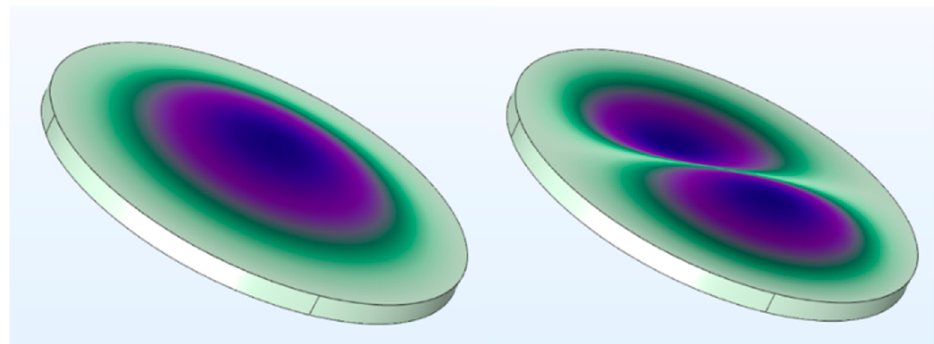
Figure 1. The first and second mode shapes of the thin plate